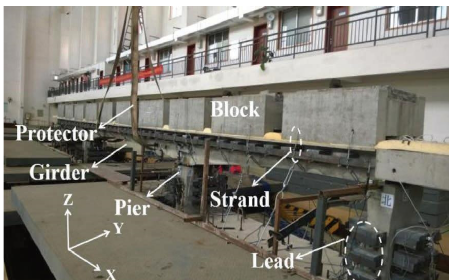
Figure 8: HSRB test